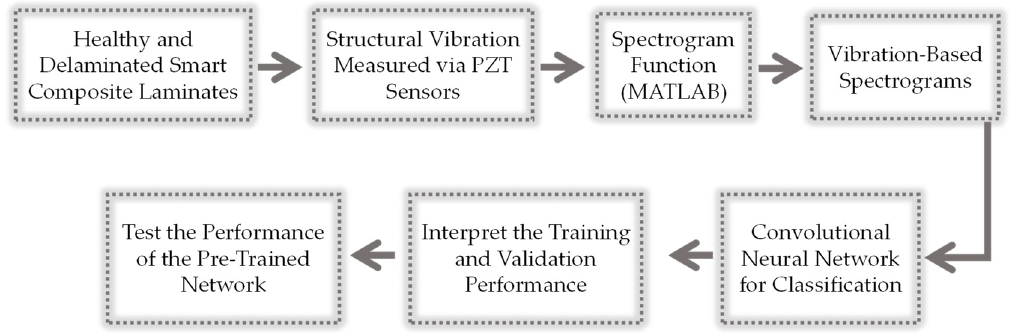
Figure3. Schematicofthedeeplearning-basedmethodologyforstructuralvibration-baseddelamination Figure 3. Schematic of the deep learning-based methodology for structural vibration-based assessment of smart composite delamination assessment of smart composite laminates.